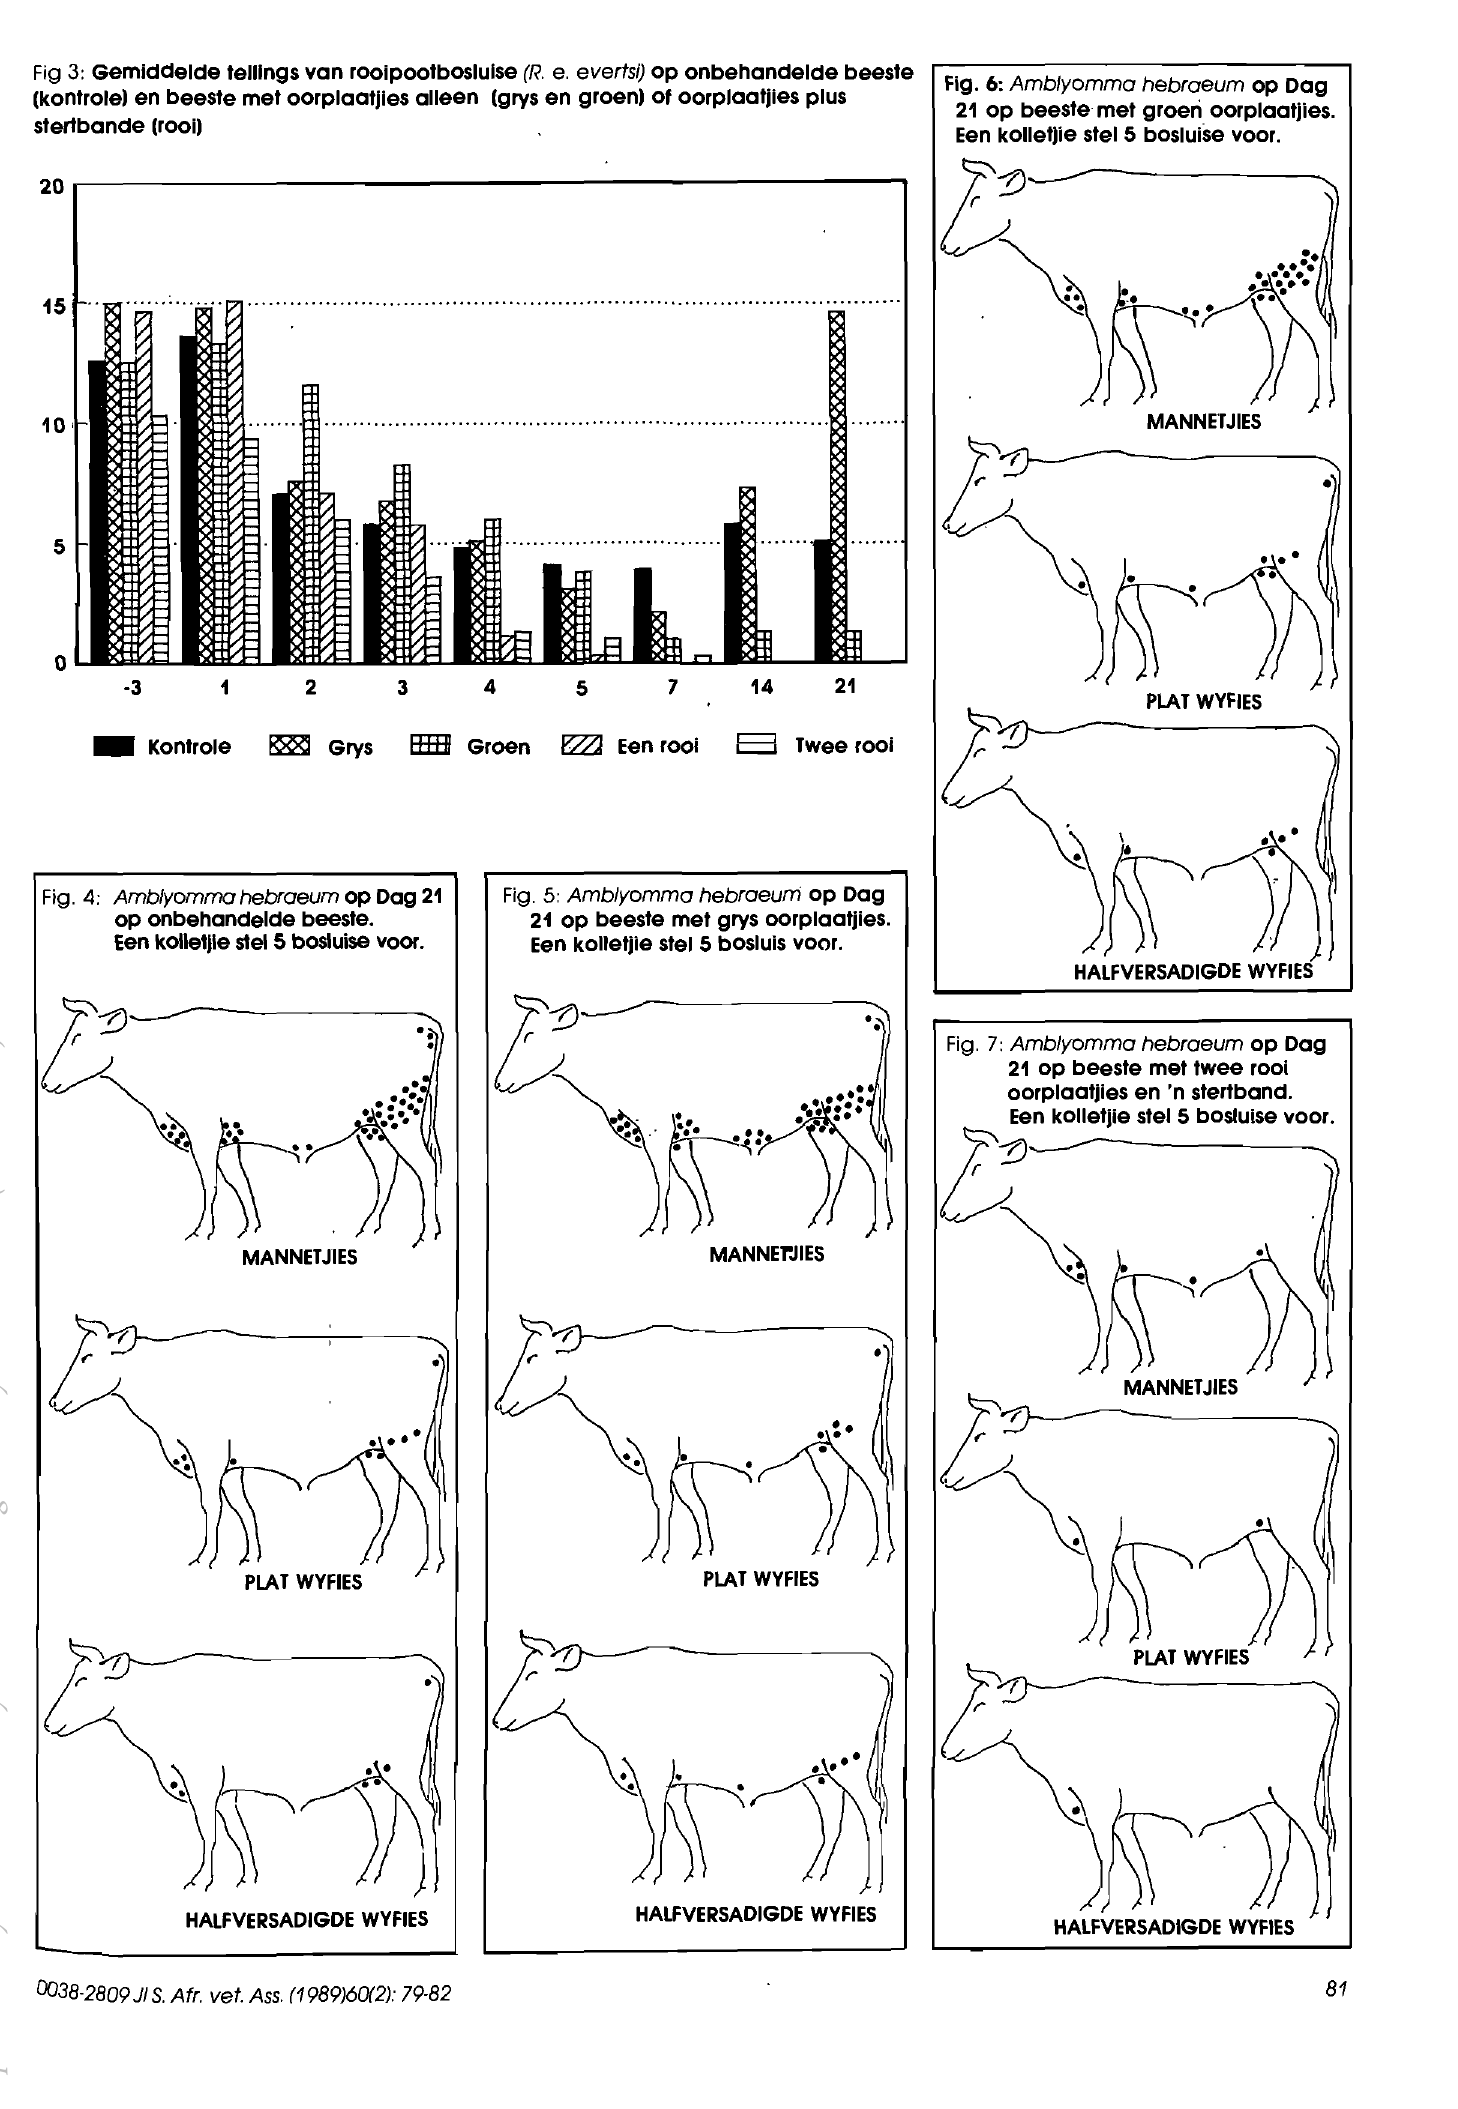
hebraeurri op Dag Fig 5: Amblyomma I rys oorplaaljies. . b esleme g 21 op e